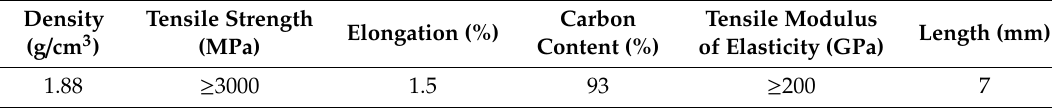
Table 4. Index parameters of carbon